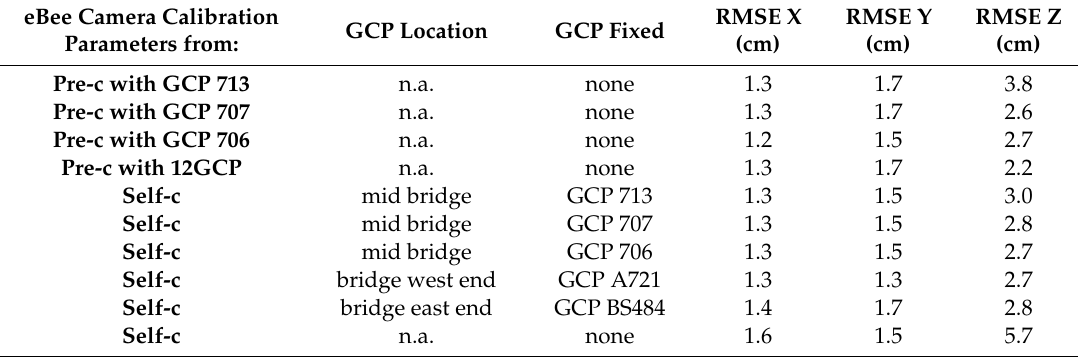
Table 4. RMSE on 57 CP coordinates computed from a Bundle Block Adjustment (BBA) of the eBee block with di ff erent camera calibration parameters sets. No GCP was fixed in the four BBA with pre-calibrated parameters, while self-calibration was executed with a single GCP in all but the last case. eBee Camera Calibration GCP Location